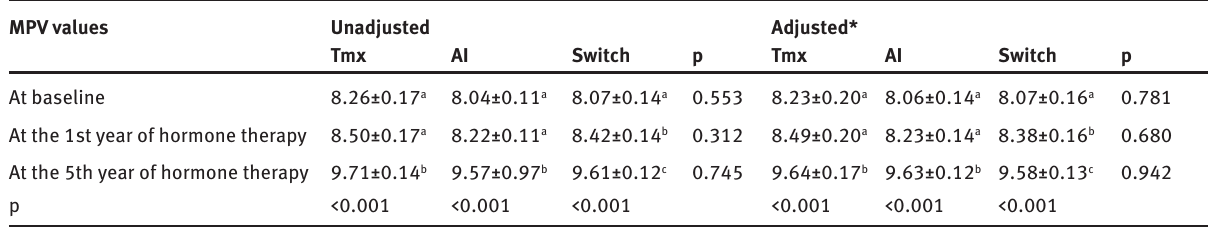
Table 4: Change in the mean platelet volume in the hormone therapy groups by years